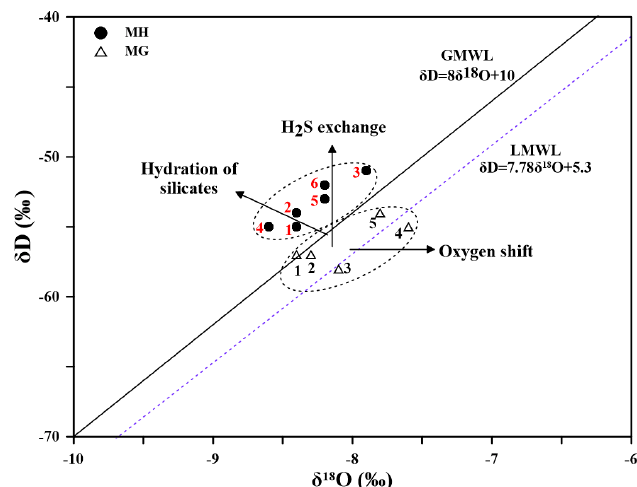
Figure 7. δ 18 O– δ D relationship for thermal waters and groundwaters in the study area. Numbers indicate the sample number of thermal waters (MH) and groundwaters (MG). (GMWL: Global Meteoric Water Line; LMWL: Local Meteoric Water Line).